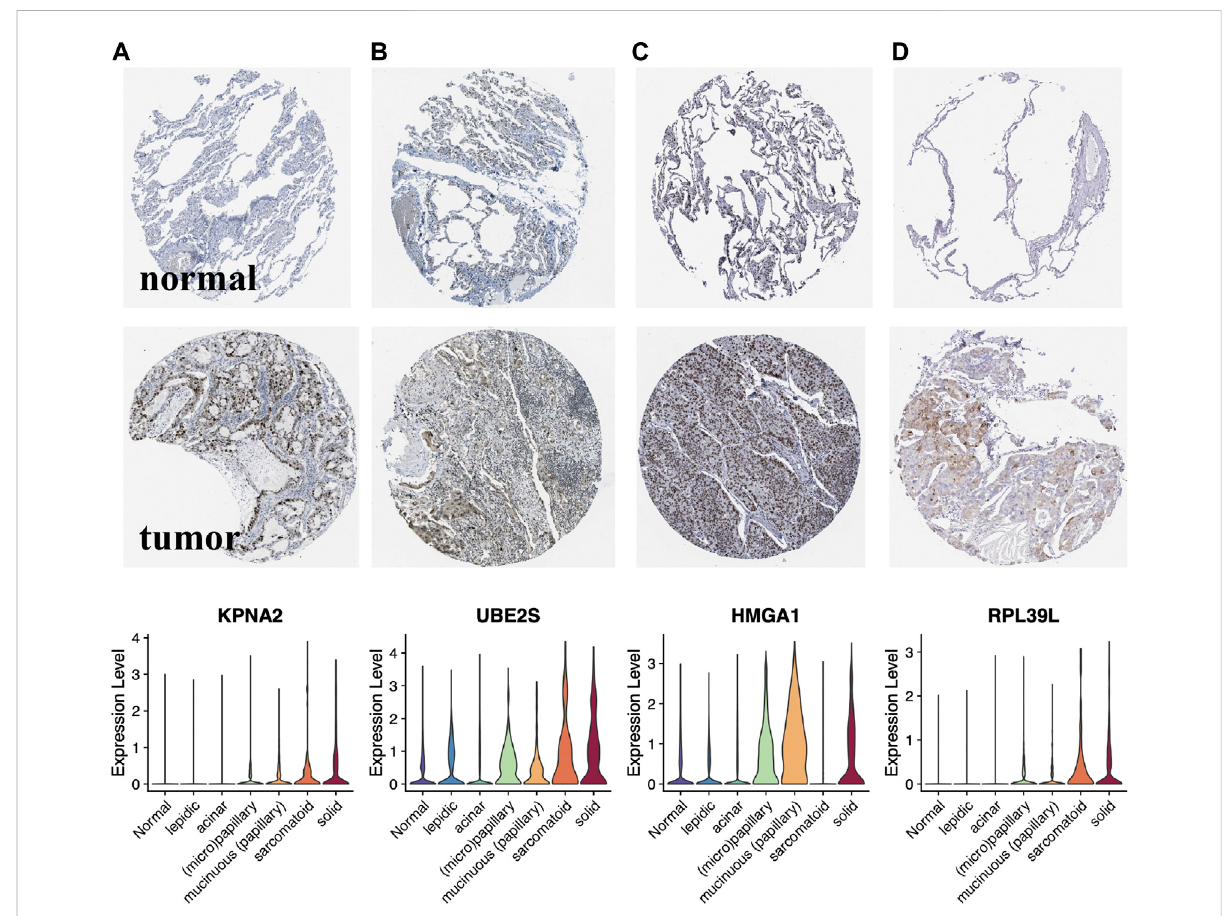
FIGURE 9 LowerexpressiongenesinthenormalrelativetotheLUADsamplesofMYC-signalingsignature. (A – D) Expressionlevelofthekeygenes(KPNA2, UBE2S, HMGA1 and RPL39L) in LUAD tumor tissues, normal tissues as well as in single cells with different degrees of